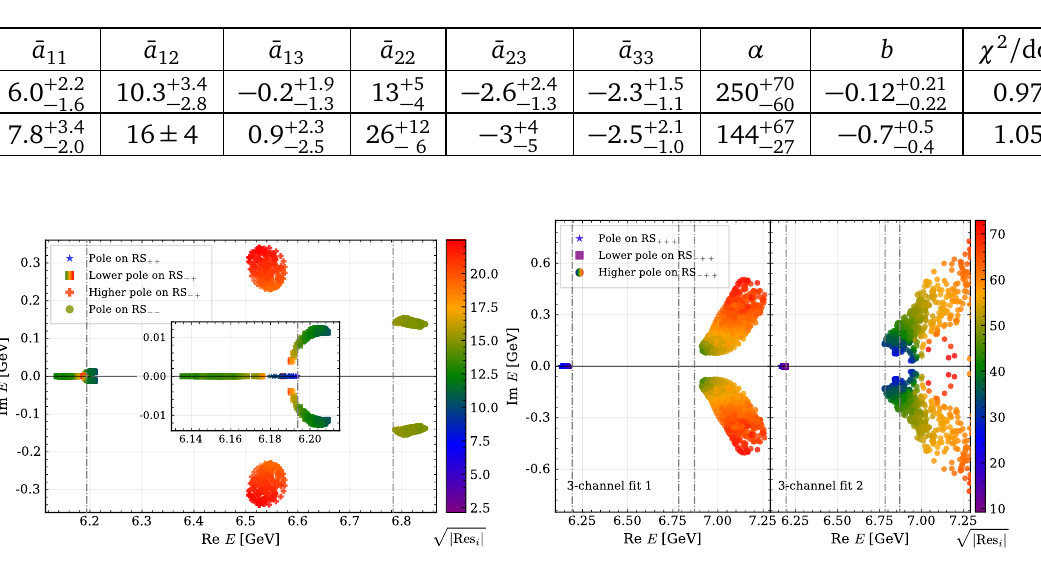
Figure 5: The poles of the amplitude for the 2- (left plot) and 3-channel (right plot) model. Adapted from Ref. [ 2 ] under arXiv.org non-exclusive license to